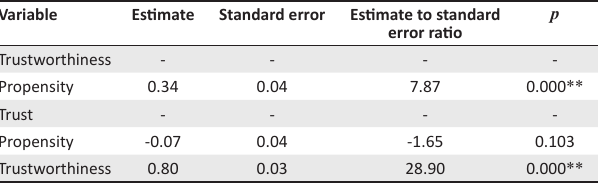
TABLE 3: Standardised regression coefficients of trustworthiness and propensity in predicting trust. Variable Estimate Standard error Estimate to standard